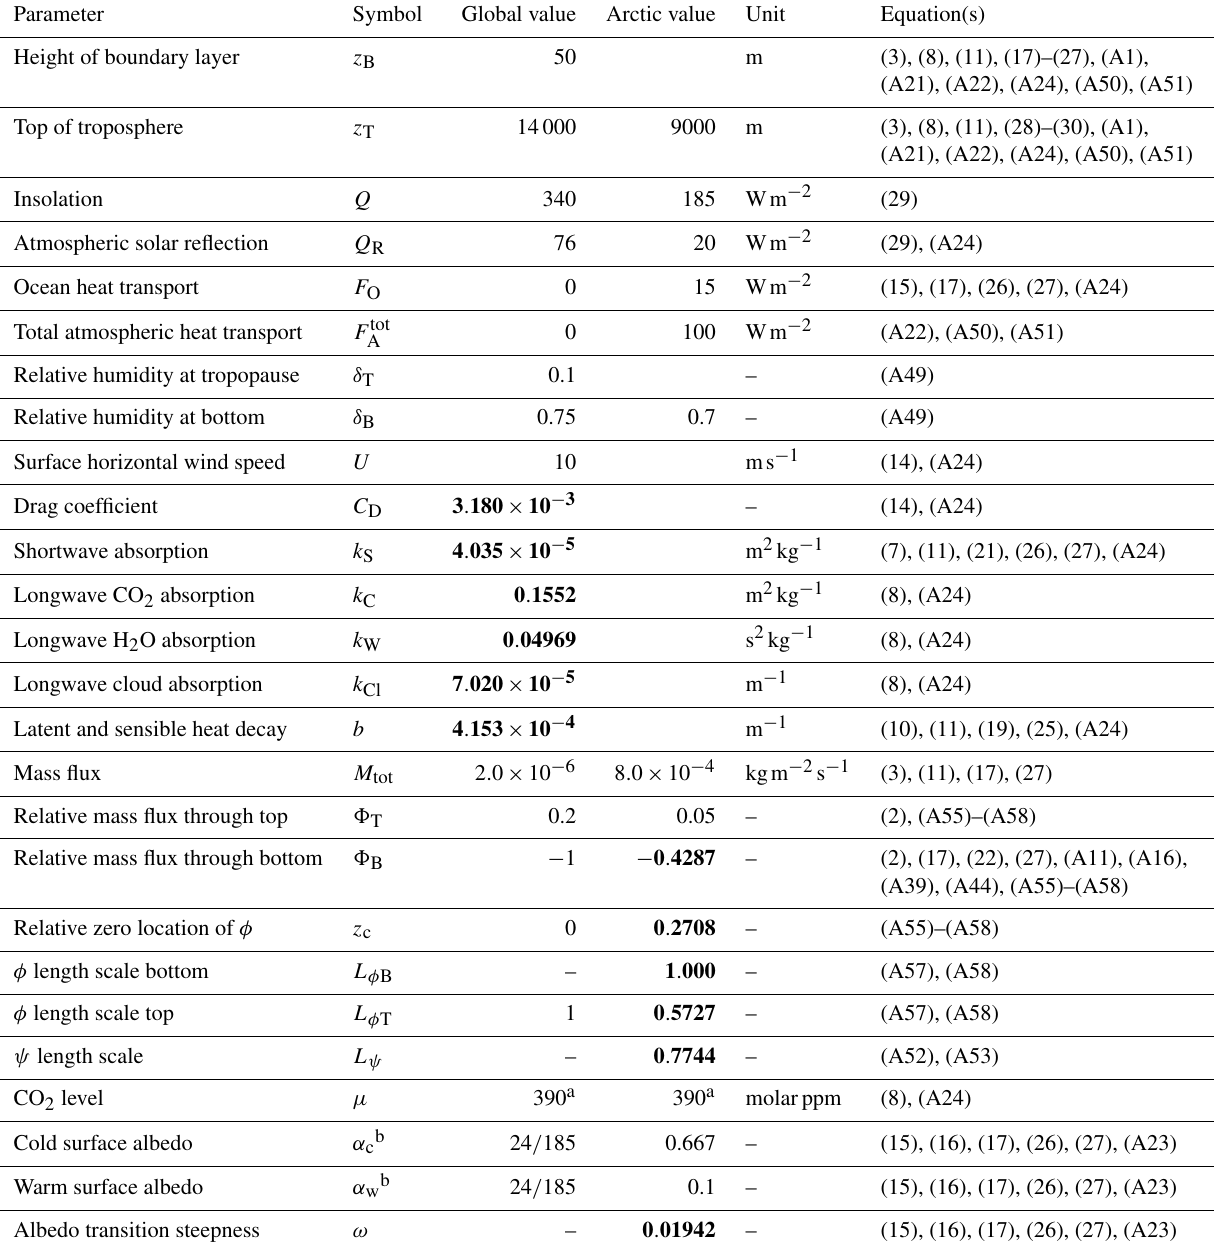
Table B2. Other model parameters. Some parameters are geographically dependent and have different values for the global and Arctic situations. An empty value in the “Arctic” column indicates the global value is used in both cases. Values that were fitted by the calibration steps described in the text are indicated in